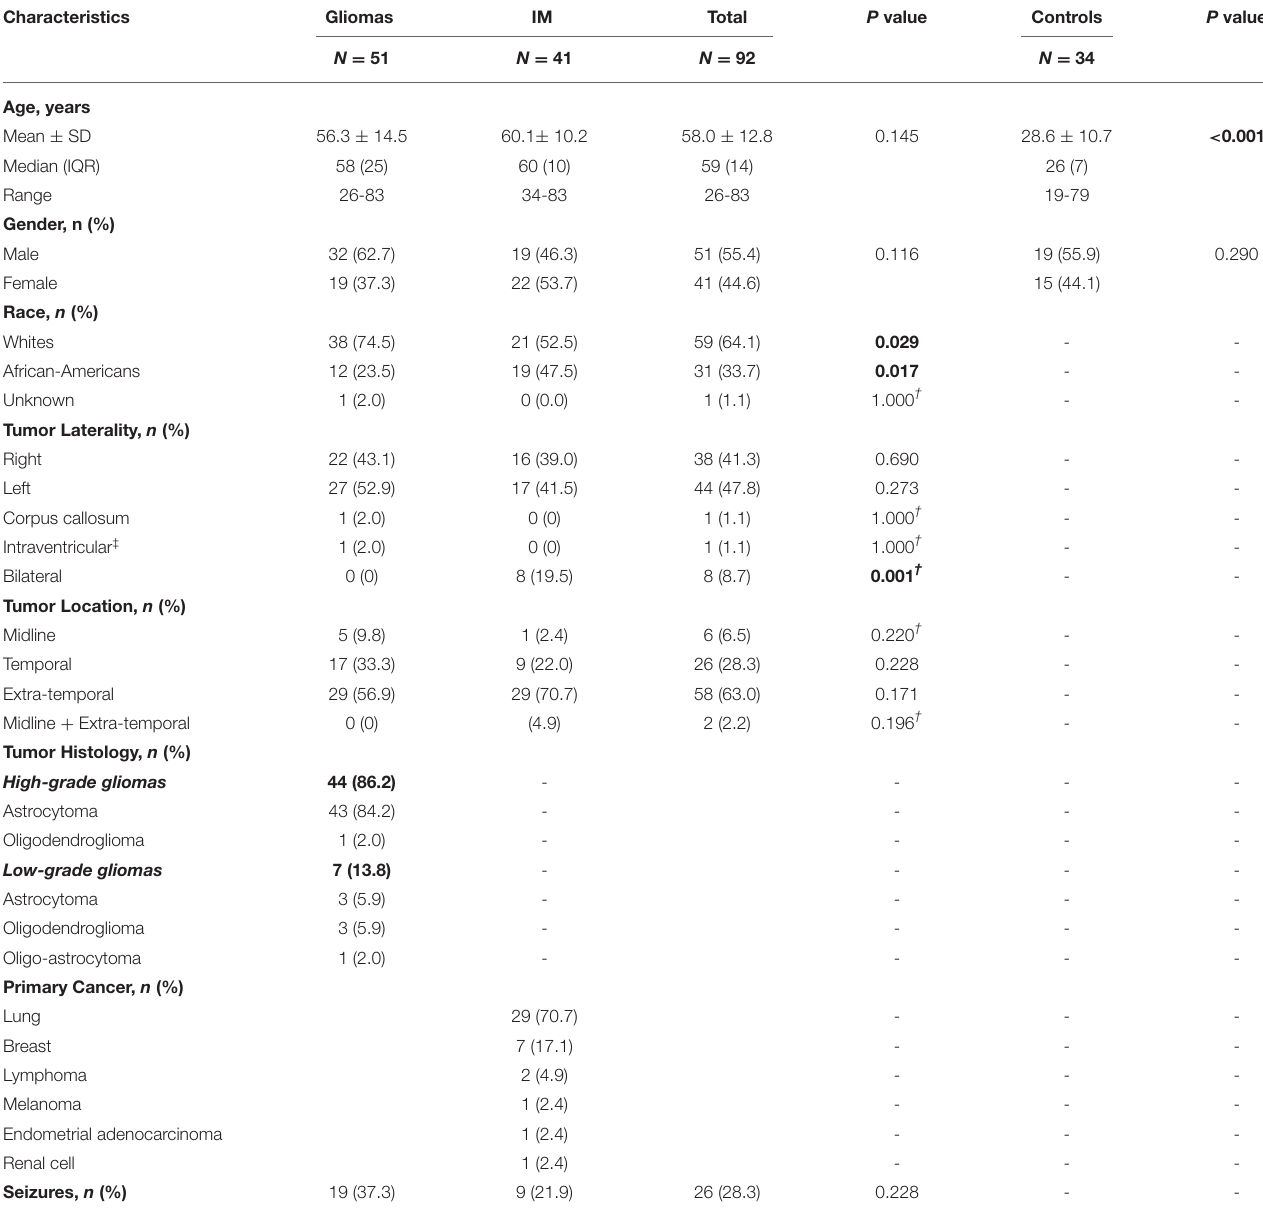
TABLE 1 | Demographics and clinical characteristics of patients with brain tumors (gliomas and IM) with respect to controls.